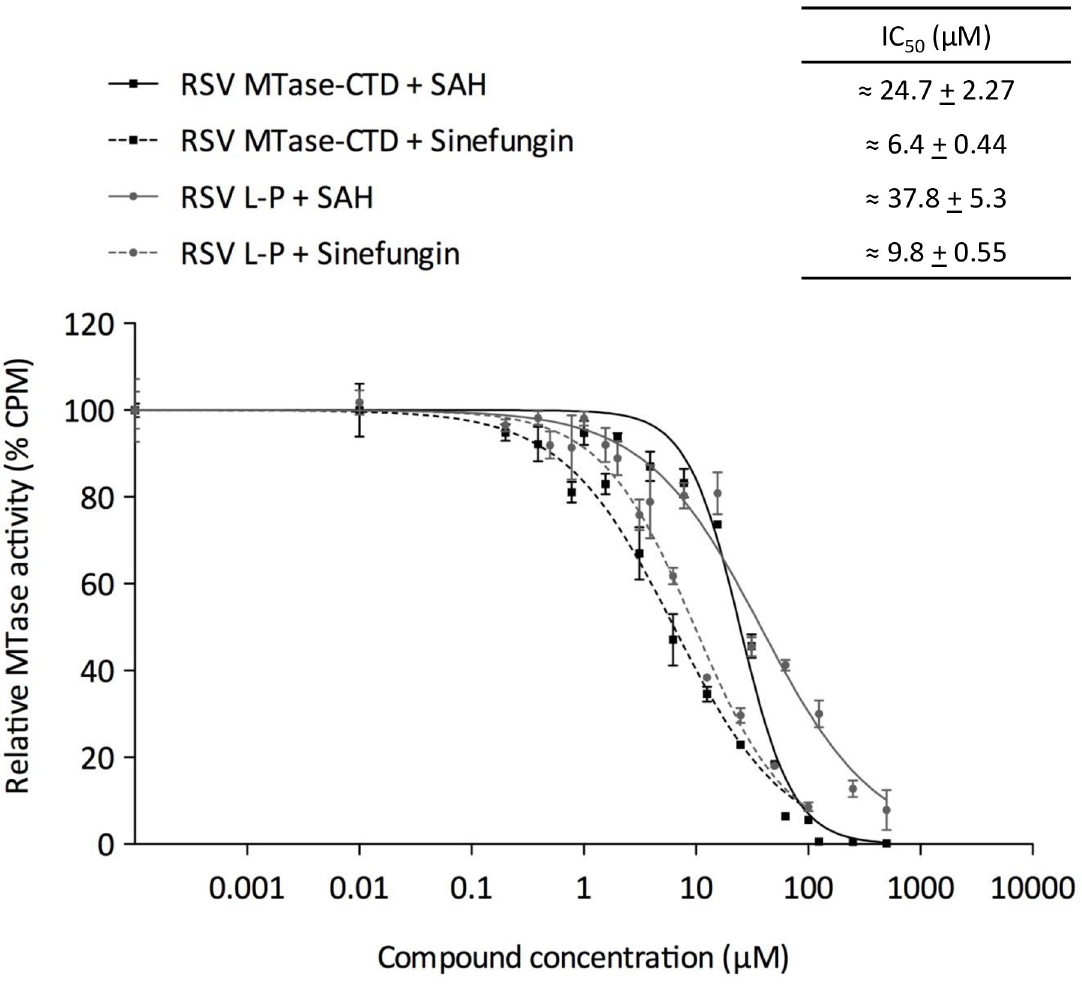
Fig 7. Inhibition of the MTase activity by SAM analogues. Increasing concentrations of SAH or sinefungin (previously dissolved in water) were incubated with 25 nM RSV MTase-CTD in a reaction mixture (40 mM Tris-HCl, pH 7.5, 2 μ M SAM and 0.1 μ M 3 H-SAM) in the presence of 0.7 μ M of GpppG-RSV 9 synthetic RNA, and with 60 nM RSV L-P complex in a reaction mixture (40 mM Tris-HCl, pH 7.5, 0.17 μ M SAM and 0.8 μ M 3 H-SAM) in the presence of 1.8 μ M synthetic RNA (GpppG-RSV 9 ). Reactions were incubated at 30˚C for 3 h. Values were normalized and fitted with Prism (GraphPad software) using the following equation: Y = 100/(1+((X/IC 50 )^Hillslope)) (n = 3; mean value ±